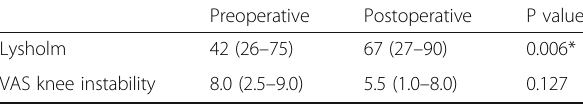
Table 2 Differences in patient-reported knee instability as measured with the Lysholm and VAS